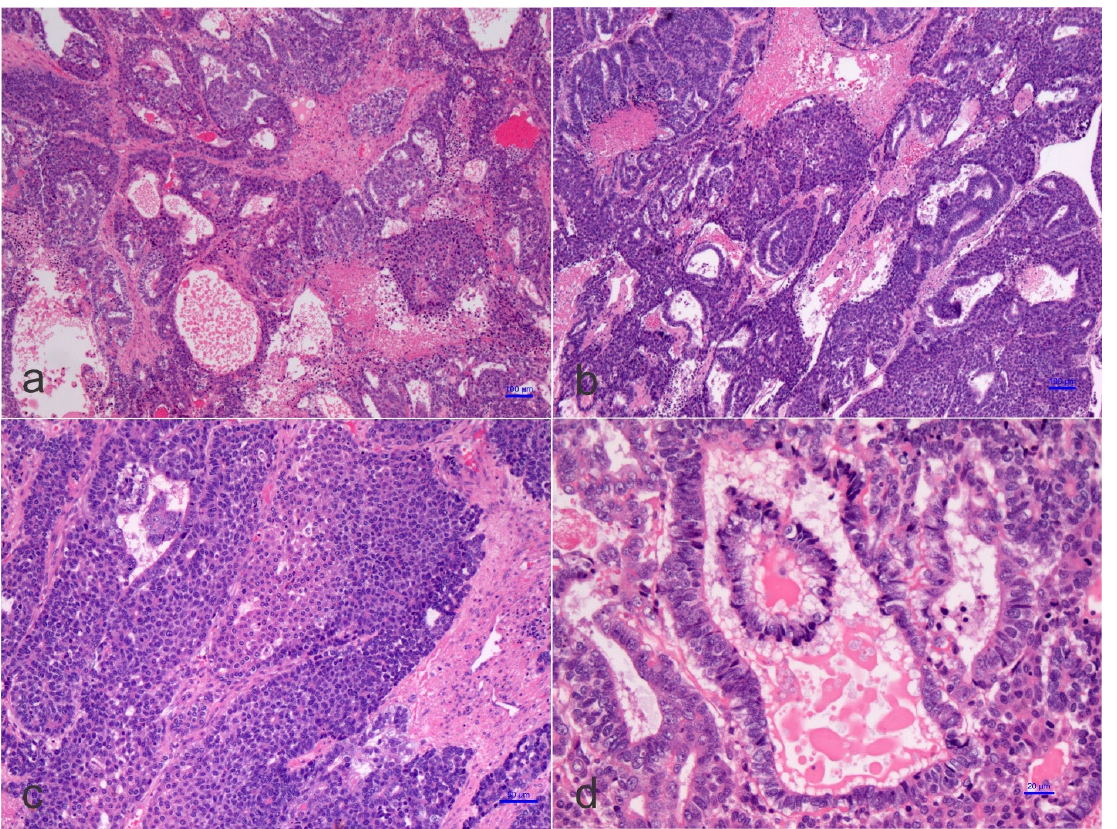
Figure 3. Histology of a mixed hepatoblastoma with teratoid features or teratoid hepatoblastoma showing fetal and embryonal portions and teratoid features with a yolk-sac-like pattern. Cords and solid portions are present and numerous mitoses are recognized with epithelial and mesenchymal components and yolk-sac-like elements ( d ), ( a – d ; hematoxylin and eosin staining, X50 original magnification, scale bar, 100 microns).